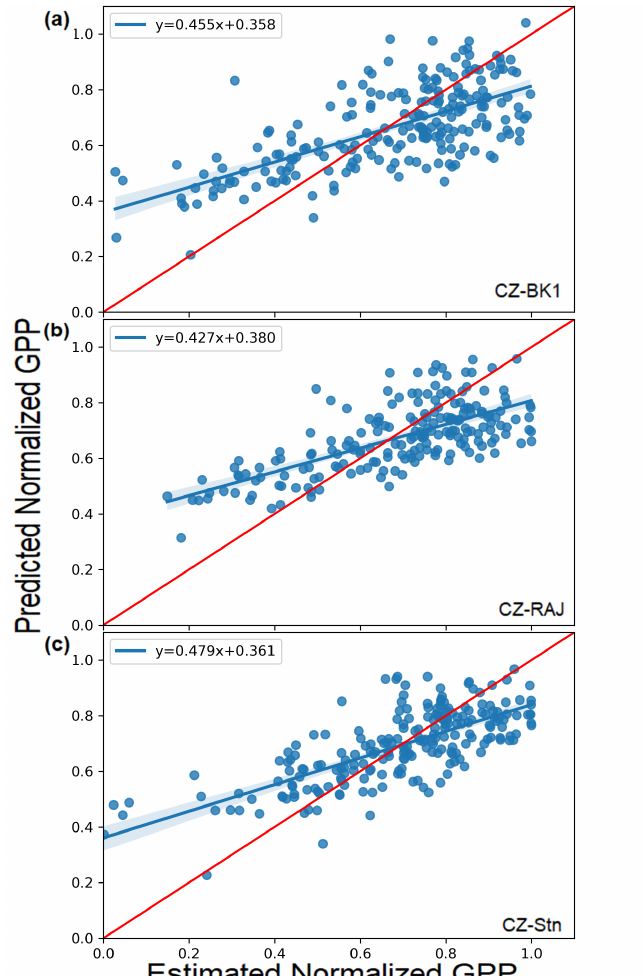
Figure 4. Comparison between estimated daily normalized gross primary productivity (GPP norm ) derived from eddy covariance measurements and predicted daily GPP norm estimated from the stepwise multiple linear regression model (SMLR) within ( a ) the wet spruce forest in Bílý K˘rí˘z (CZ-BK1), ( b ) the dry spruce forest in Rájec (CZ-RAJ), and ( c ) the beech forest in Štítná (CZ-Stn). 1:1 relationship between the predicted GPP norm and estimated GPP norm values from the SMLR are represented by the red line. The shaded blue area represent the 95% confidence